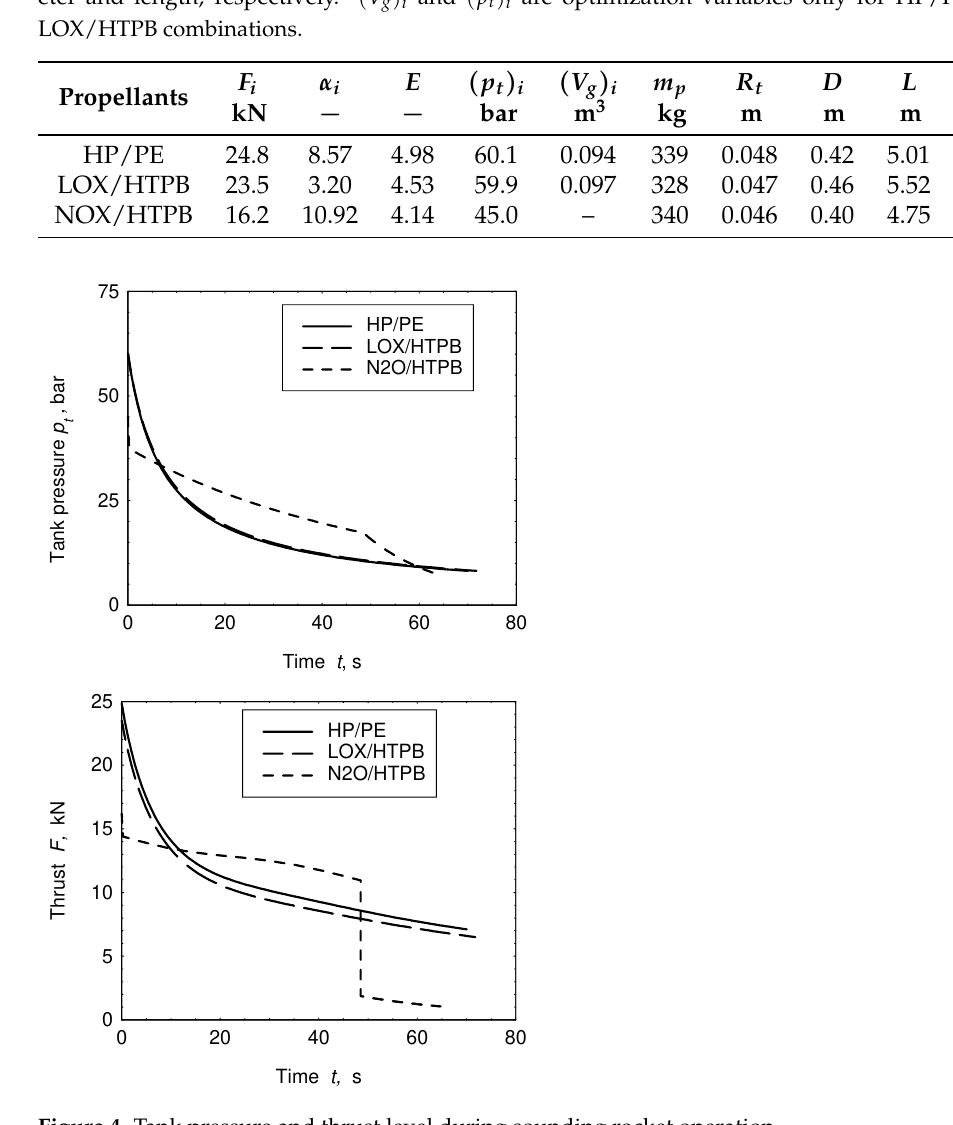
Figure 4. Tank pressure and thrust level during sounding rocket